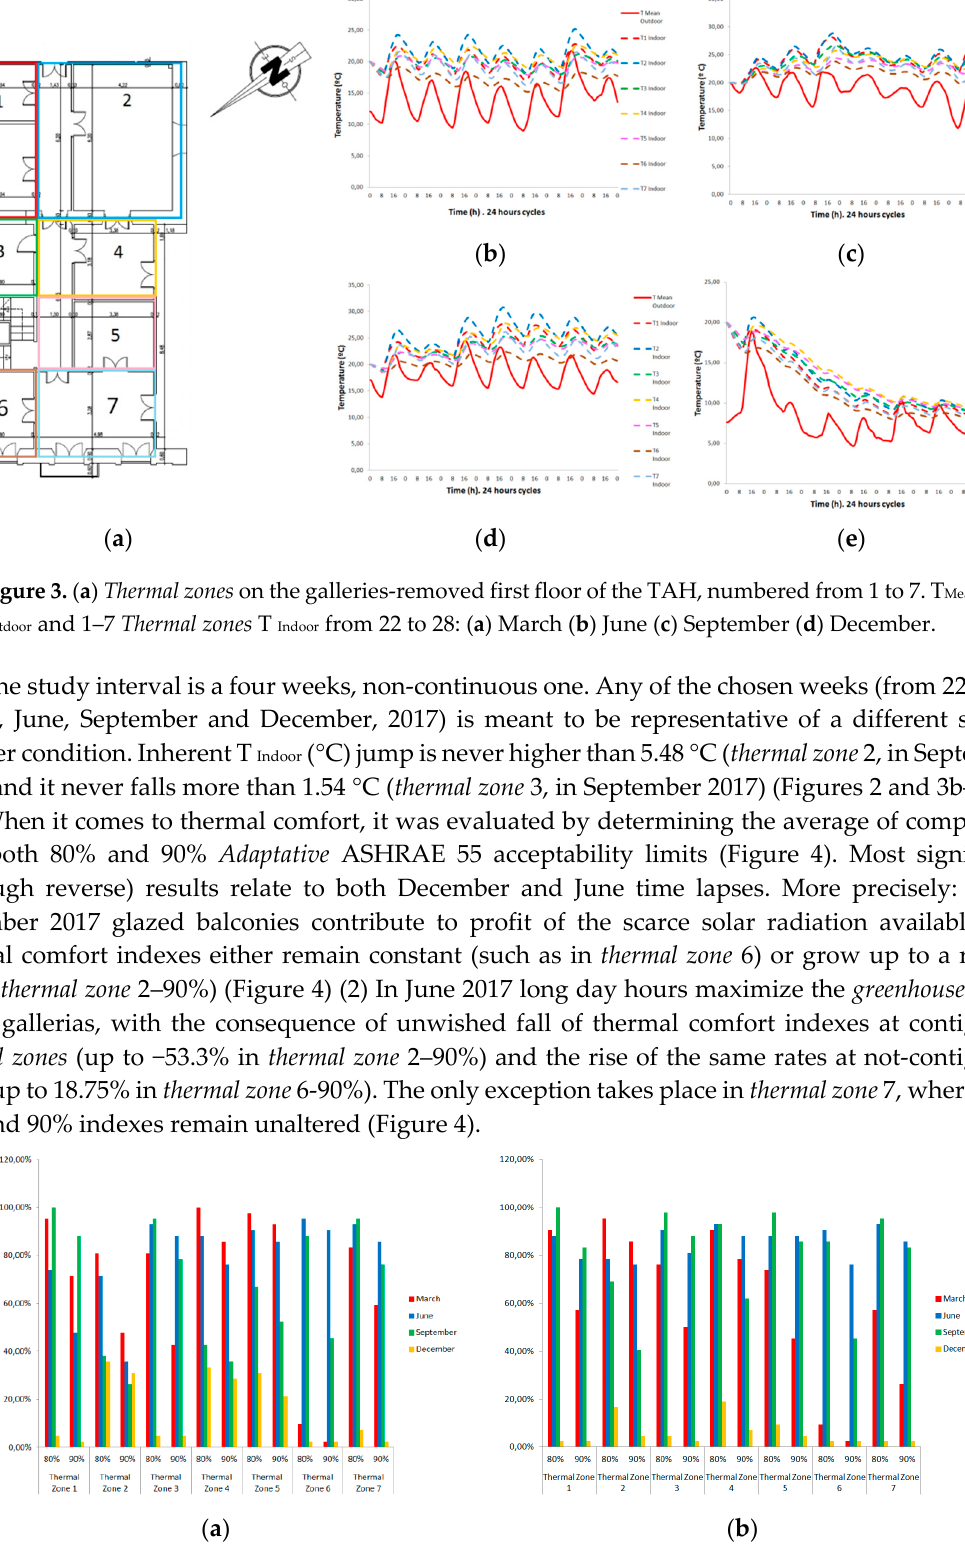
Figure 4. Rate of compliance of 80% and 90% Adaptative ASHRAE 55 acceptability limits, at 1–7 thermal zones on the first floor of the TAH: ( a ) With galleries. ( b ) Without